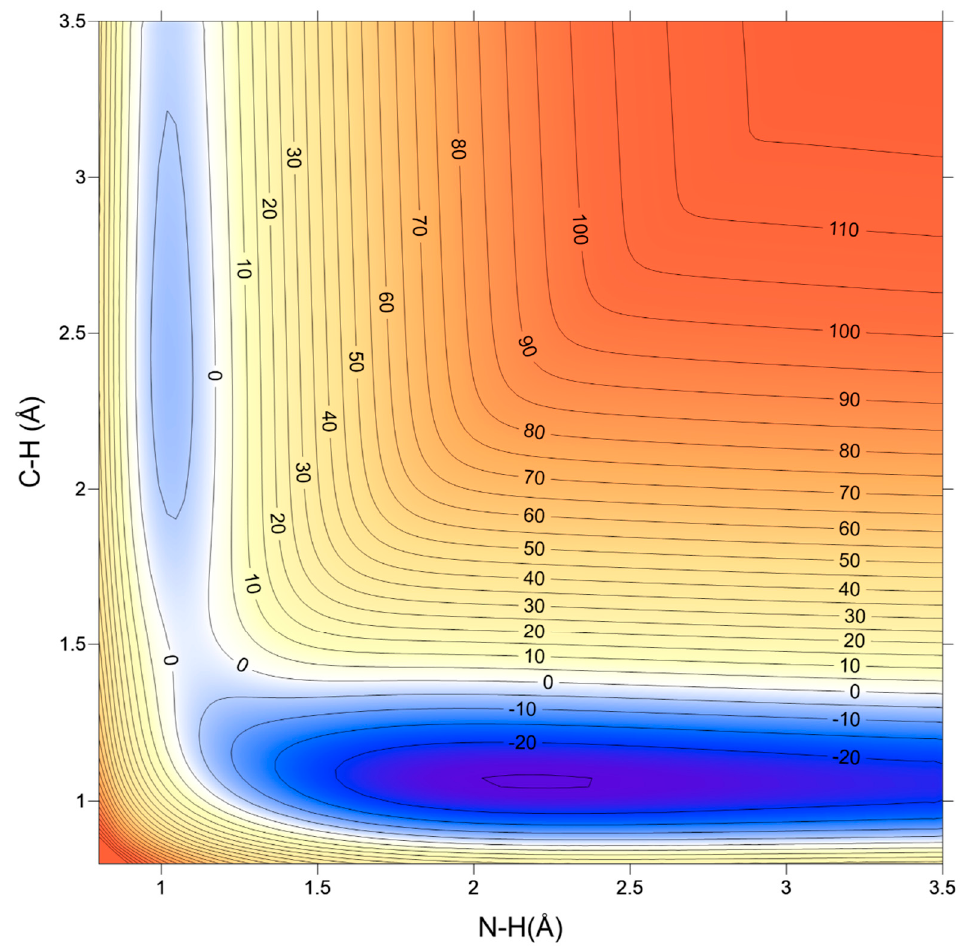
Figure 3. Schematic 2D representation of the PES-2020 surface describing the reactive system of CN + NH3 as a function of the broken and formed bonds, N–H and H–C, respectively, in Å. The other internal coordinates were fixed at the values in the saddle point. Energies are shown in kcal·mol − 1 . The reactant and product complexes appear clearly in the entrance (upper-left zone) and exit (lower-right zone) channels in the plot.